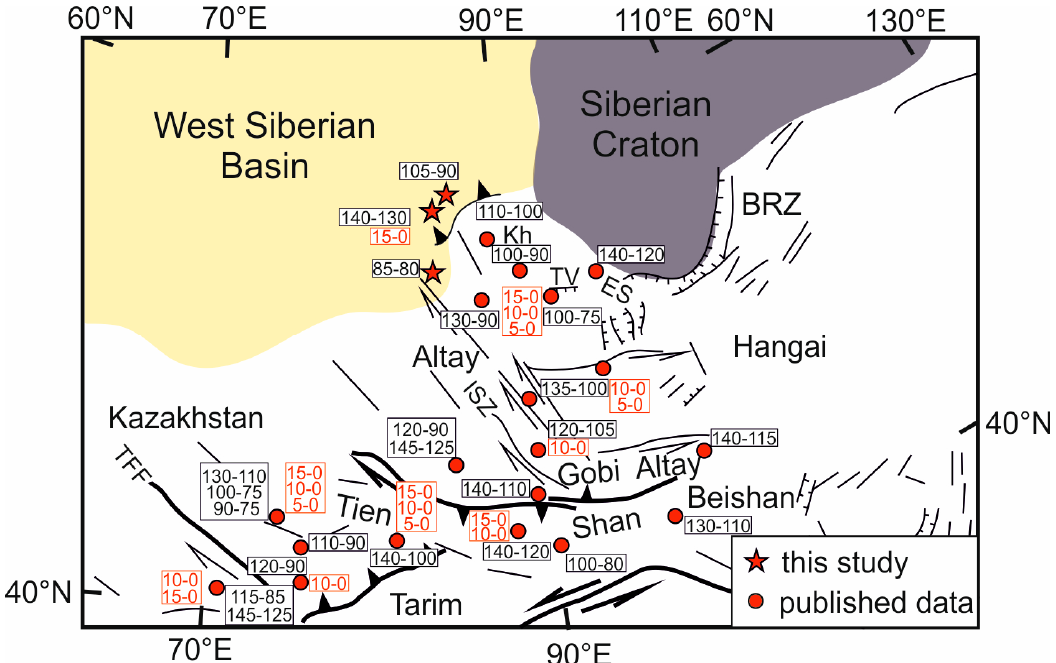
Figure 6. Schematic tectonic map with Cretaceous AFT ages (in black) and a Late Neogene cooling pulse (in red) based on AFT age ranges, apatite U-Th-He dating (the apatite He system with a closure temperature range between ~45-75 °C [68] is more sensitive to near-surface processes than the AFT system), and thermal modeling in the Central Asia Orogenic Belt area to the south of the West Siberian Basin. Strike-slip faults are lines with lateral direction of movement shown by the arrows. Extensional structures are shown by striped lines. ISZ — Irtysh shear zone, TFF — Talas – Fergana fault, ES — East Sayan fault, BRZ — Baikal rift zone, TV — Tuva, Kh — Khakassia.